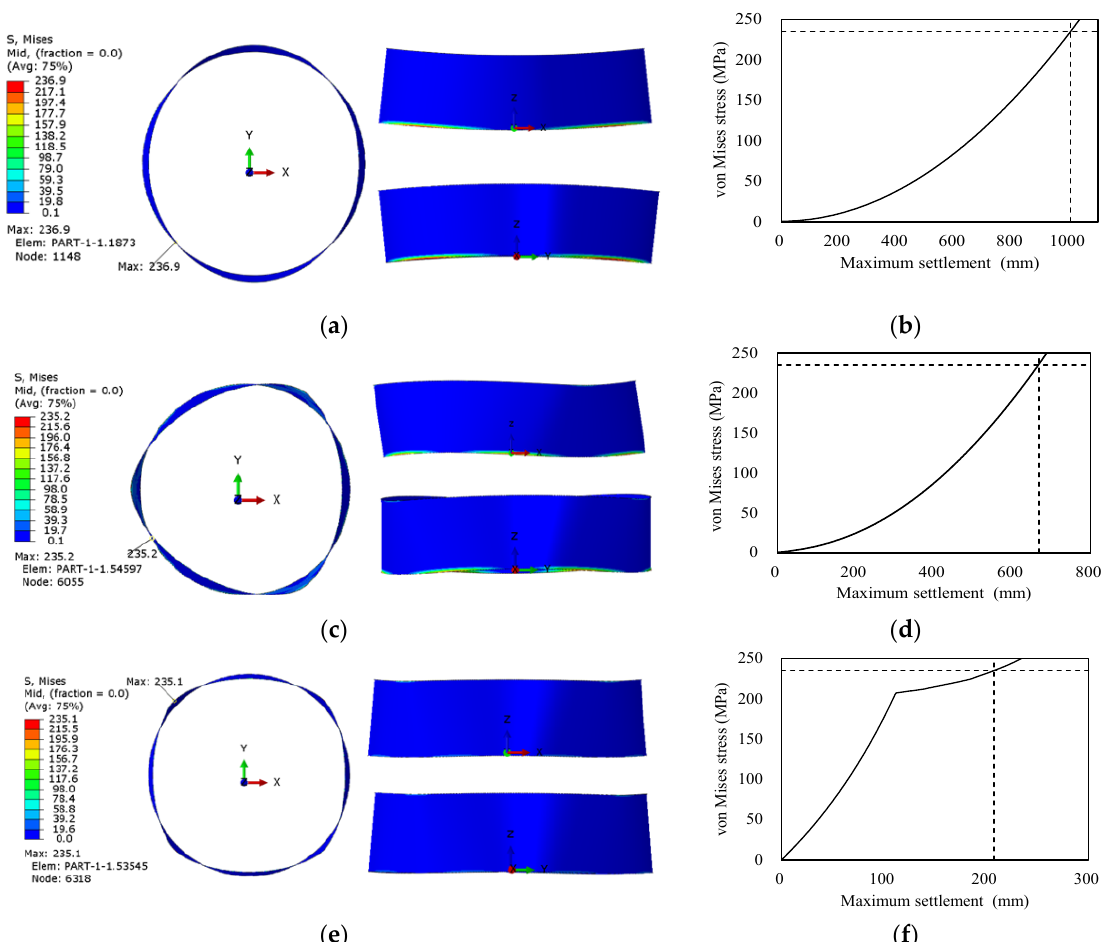
Figure 11. The contour of von Mises for the deformed tank shell and the settlement vs von Mises membrane stress for different harmonic wave numbers: ( a ) and ( b ) for n = 2; ( c ) and ( d ) for n = 3; ( e ) and ( f ) for n =